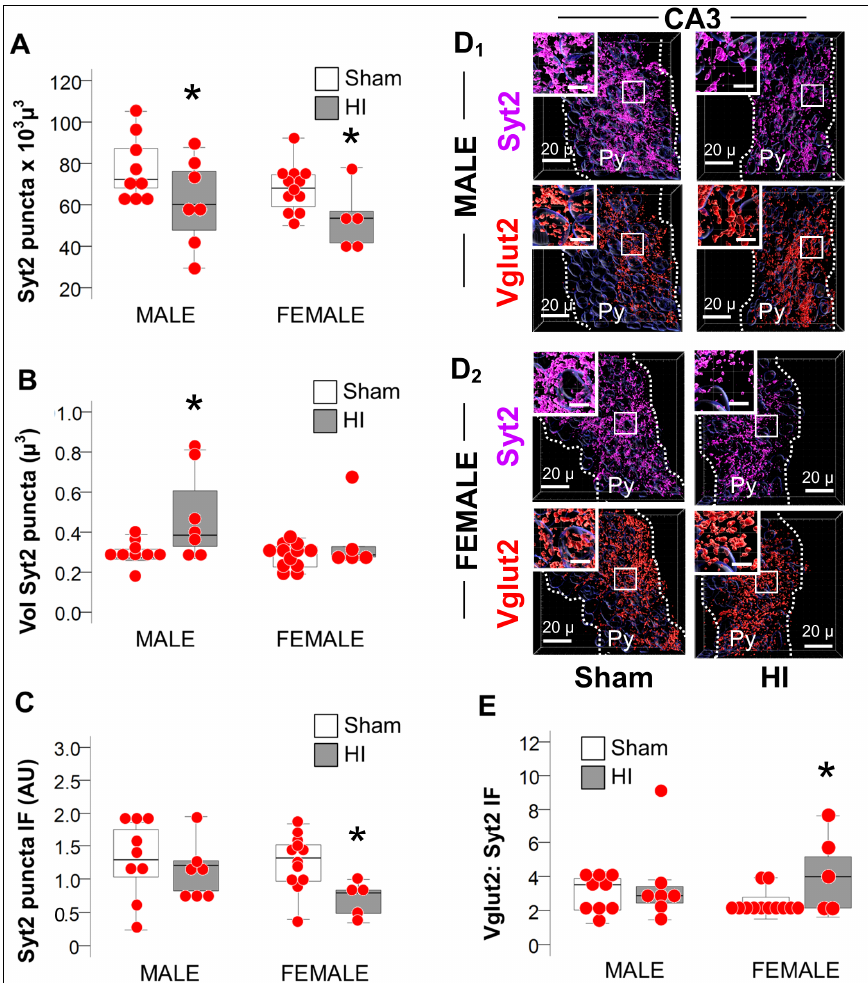
Figure 4. Decreased Syt2 puncta and predominance of excitation in female mice after HI. ( A ) The number of the puncta expressing the PV-specific presynaptic marker Syt2 was similarly decreased in the CA3 of both males and females HI-injured mice (grey box) compared to sham (white box). ( B ) Unlike, in female mice, CA3 Syt2 + puncta from HI-injured male mice (grey box) were larger in volume compared to sham (white box). ( C ) Syt2 immunofluorescence per puncta in arbitrary units (AU) was decreased in HI-injured female mice (grey box) compared to sham (white box), but not in male mice. ( D ) Representative Imaris reconstructions of Syt2 (magenta) and the glutamatergic Vglut2 (red) presynaptic markers within the pyramidal cell layer (Py) for male ( D 1 ) and female ( D 2 ) sham and HI-injured mice are shown. Radiatum (Rd) and Oriens (Or) layers were negated, to only account for perisomatic synapses within the Py. ( E ) The Vglut2:Syt2 ratio was greater in the HI-injured CA3 of female mice (grey box) supporting the EcFP LTP results shown in Figure 2D. Quantifications are shown as hybrid box, whisker and dot plots. *, p <0.05 (Mann-Whitney U test; n = 6, per sex per group).